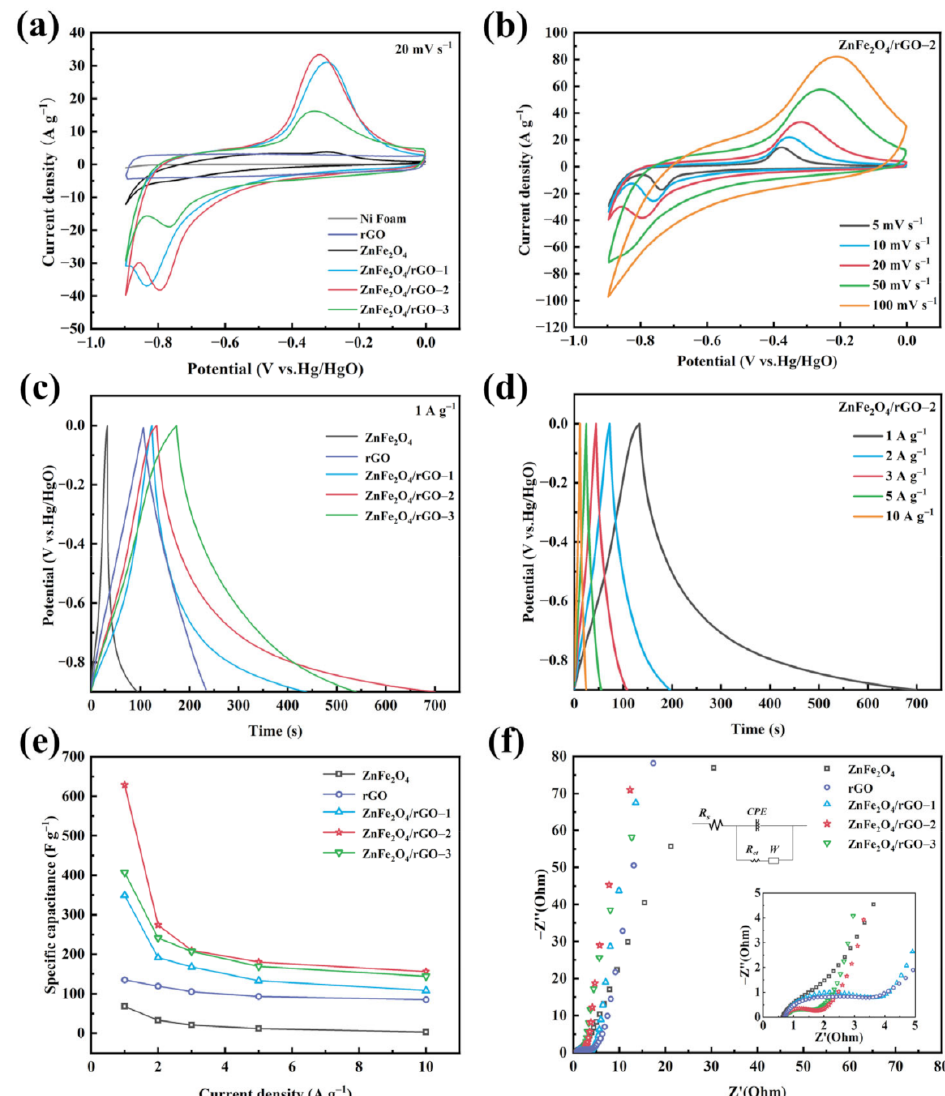
Figure 6. ( a ) CV curves of ZnFe 2 O 4 , rGO, ZnFe 2 O 4 /rGO − X (X = 1, 2, 3) at 20 mV s − 1 and ( b ) ZnFe 2 O 4 /rGO − 2 at different scan rate, ( c ) charge/discharge curves of the ZnFe 2 O 4 , rGO, ZnFe 2 O 4 /rGO − X (X = 1, 2, 3) at 1 A g − 1 and ( d ) ZnFe 2 O 4 /rGO − 2 at 1 A g − 1 , ( e ) rate perfor- mance and ( f ) Nyquist plots of ZnFe 2 O 4 , rGO, ZnFe 2 O 4 /rGO − X (X = 1, 2,